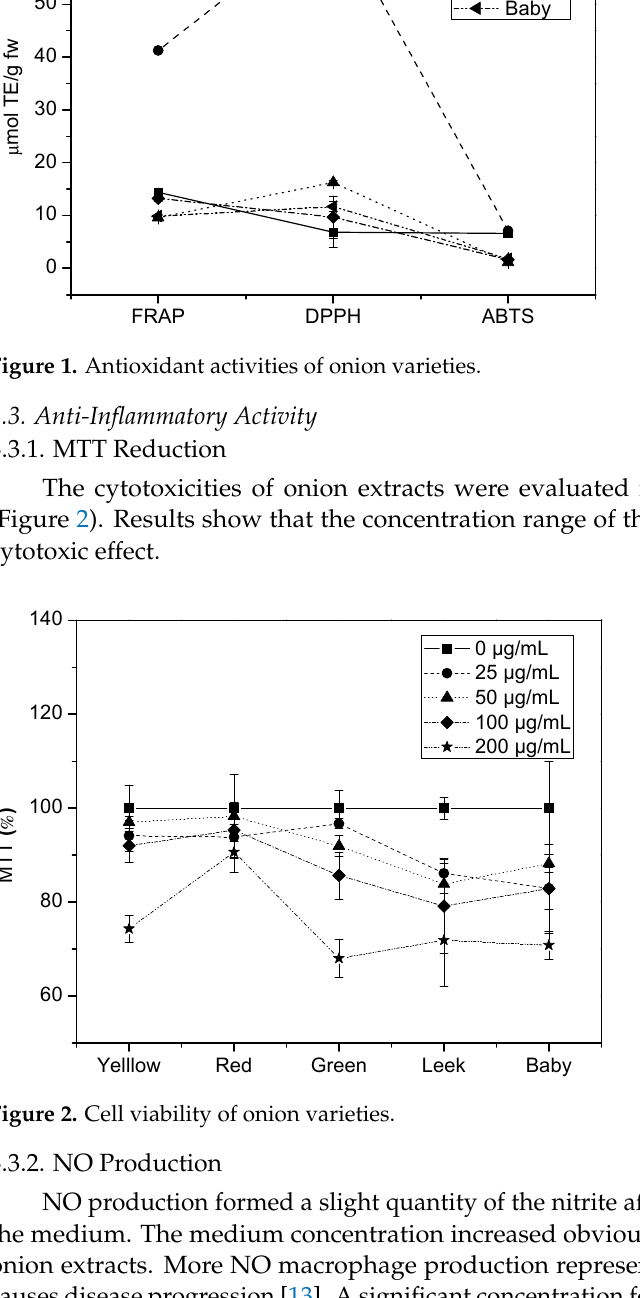
Figure 2. Cell viability of onion varieties.